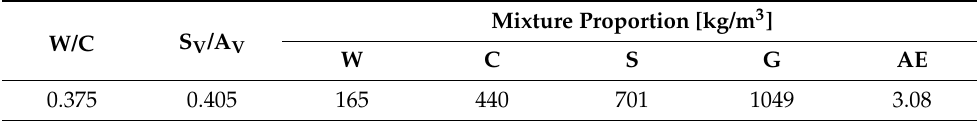
Table 2. Properties of the concrete cylinders used in this study.